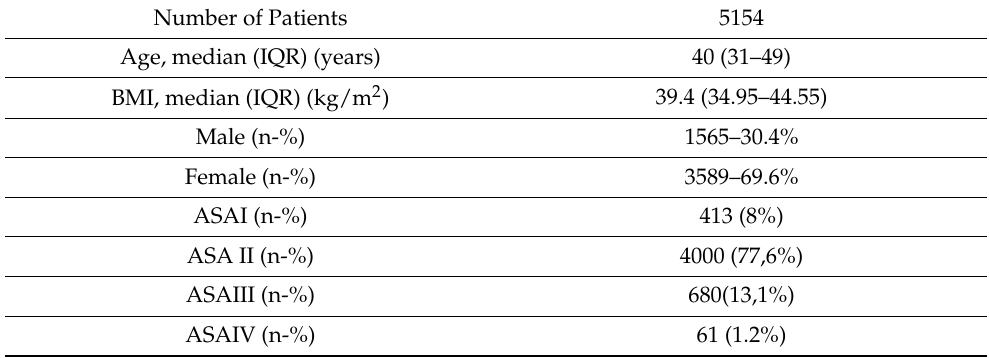
Table 2. The demographics of patients with LSG (2014–2022).